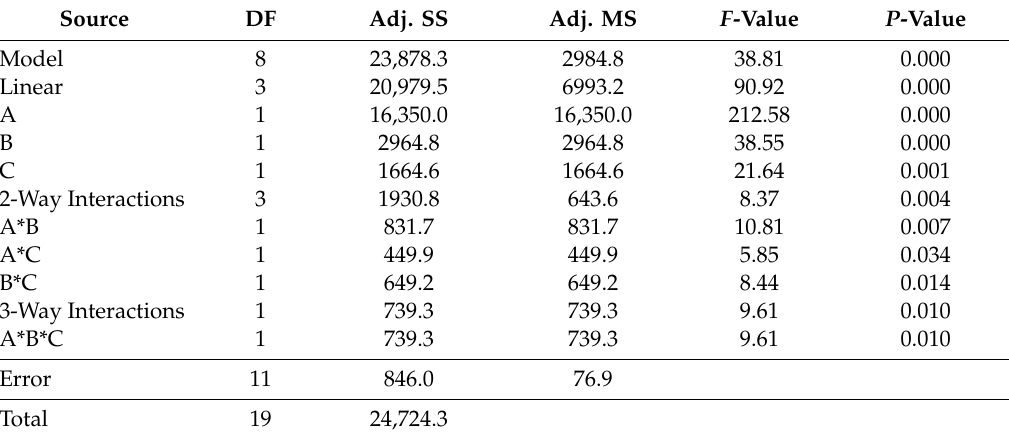
Table 12. Analysis of variance for principal stress (six locking